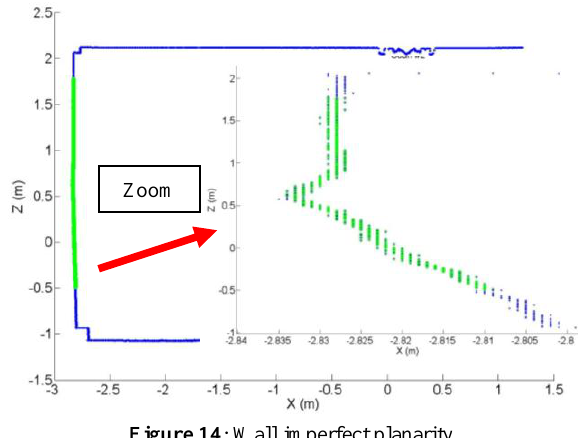
Figure 14 : Wall imperfect